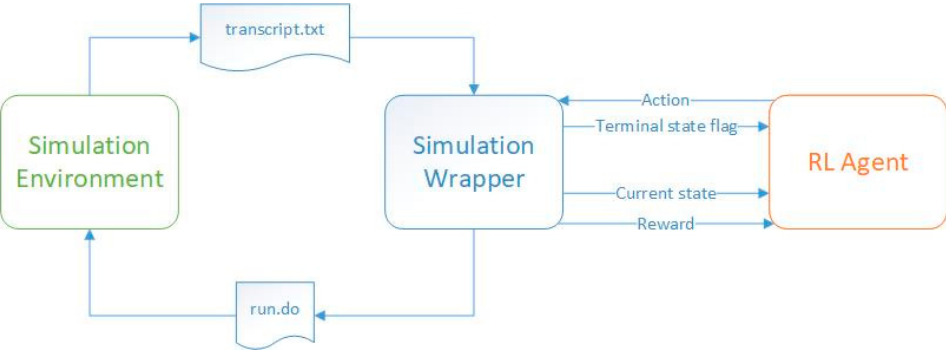
Figure 1. Information transferred between the code representing the reinforcement learning agent and the simulation environment containing the DUT during the training process.